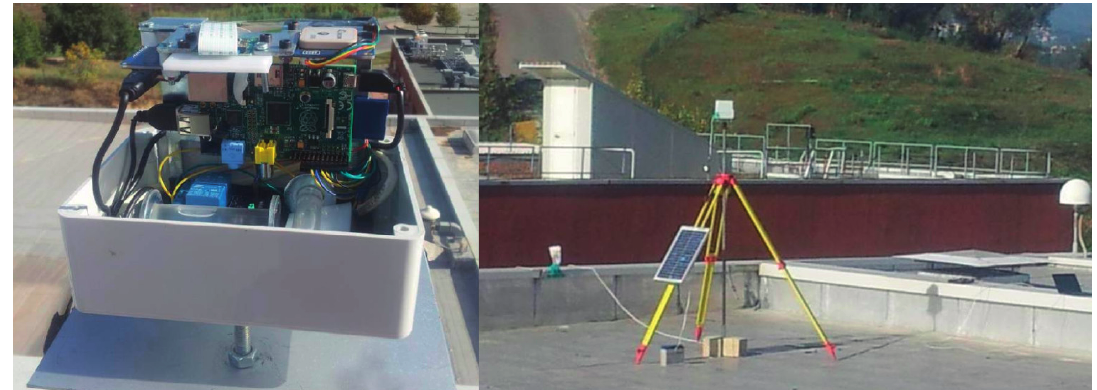
Figure 12. ( Left ) The sensor assembled; ( Right ) The sensor positioned on the terrace